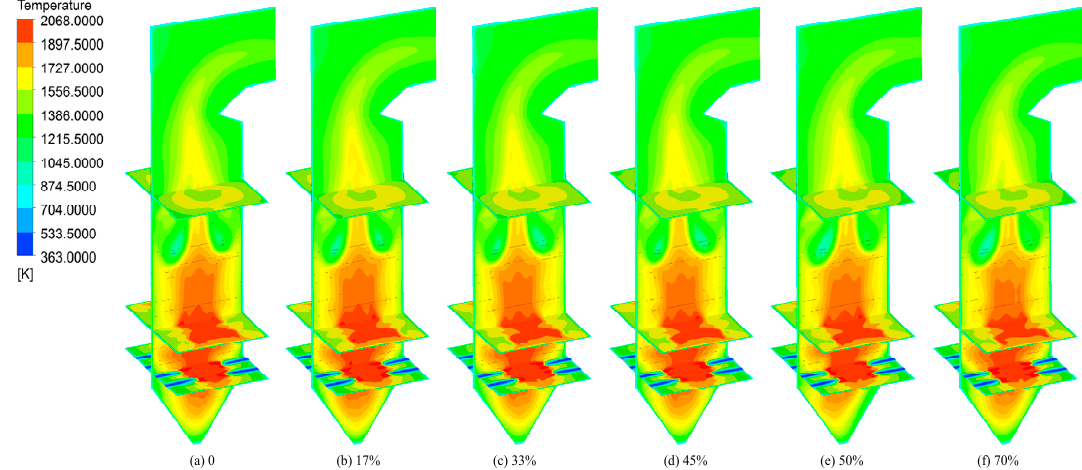
Figure 5. The temperature contours within furnace at various semi-coke blending ratios.